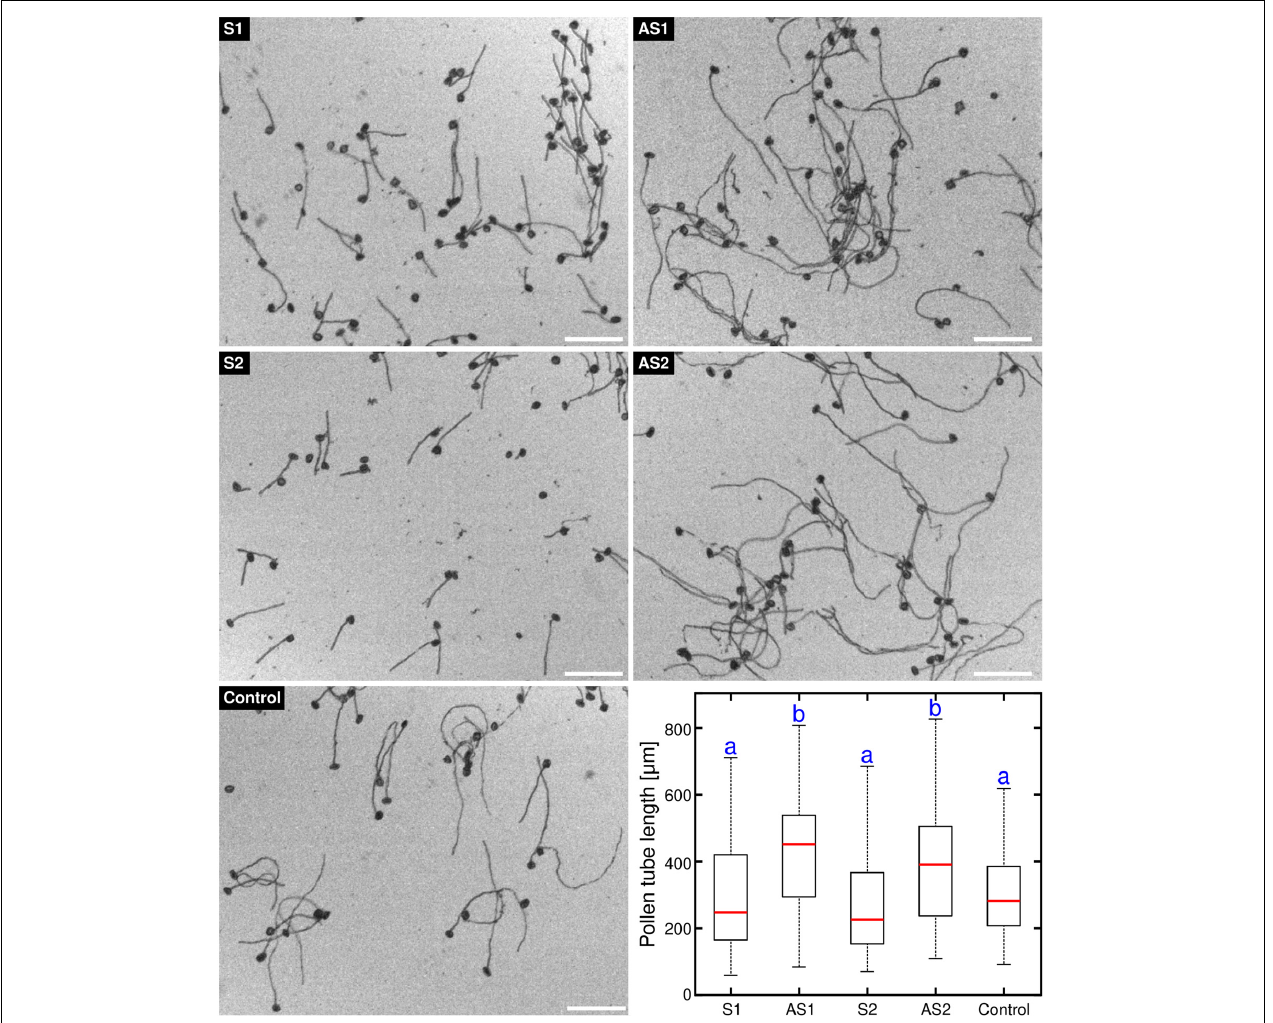
FIGURE 1 | Antisense oligonucleotide-mediated knock-down of tobacco EXO70C2 leads to faster pollen tube growth. Tobacco pollen tubes were incubated with 50 µ M of two different antisense (AS1,AS2) and corresponding sense (S1,S2) oligodeoxynucleotides specific for EXO70C2 . Non-treated wild type pollen was used as control. Microscopic images and boxplot show data from a representative experiment that was repeated twice with identical trend. At least 140 cells were measured per treatment. Different letters indicate significant differences between samples ( P < 0.001). Bar, 200 µ m.